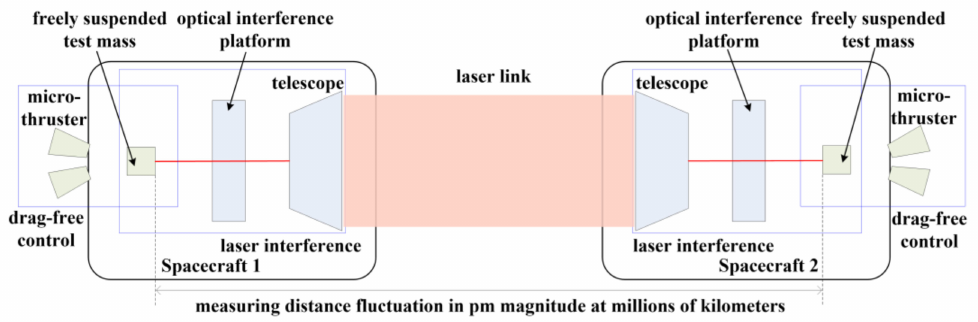
Figure 2. Detection of space gravitational waves by laser interferometry (side